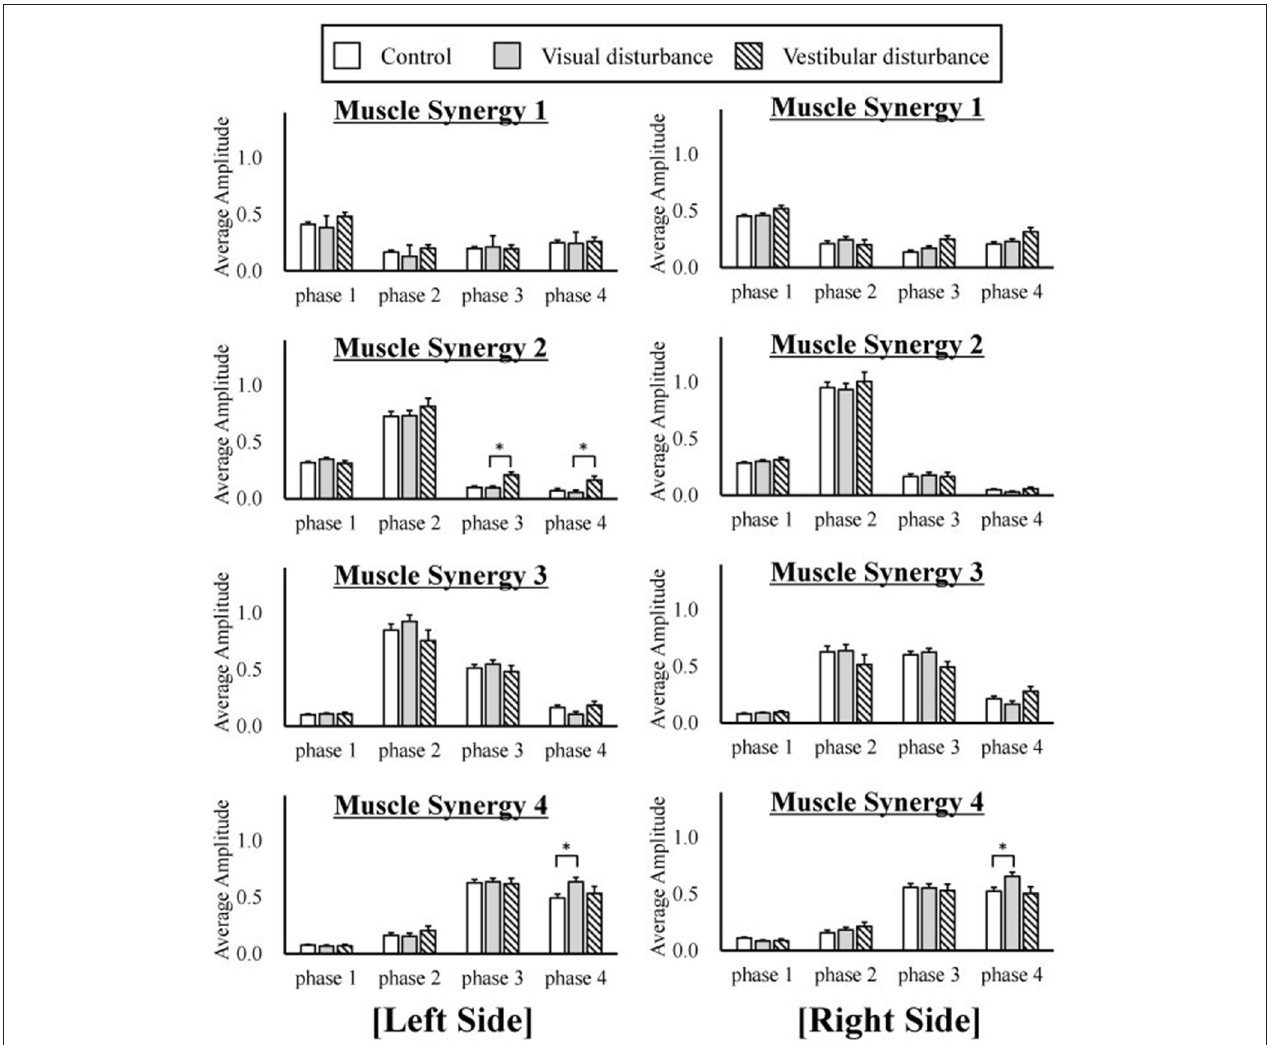
FIGURE 5 | The average and standard deviation of the temporal patterns of the muscle synergies under three different conditions are displayed. The amplitudes of the temporal patterns were averaged in each phase of the sit-to-stand motion. The results from the left are displayed on the left of the figure, and the results from the right side are displayed in the right. This graph is based on 120 samples in total. A statistical test showed that muscle synergy 2 extracted from the left side had a larger amplitude during phases 2 and 3 under the vestibular-disturbance condition than under the visual-disturbance condition. In addition, the amplitude of the muscle synergy 4 increased under the visual-disturbance condition than under the control condition in both